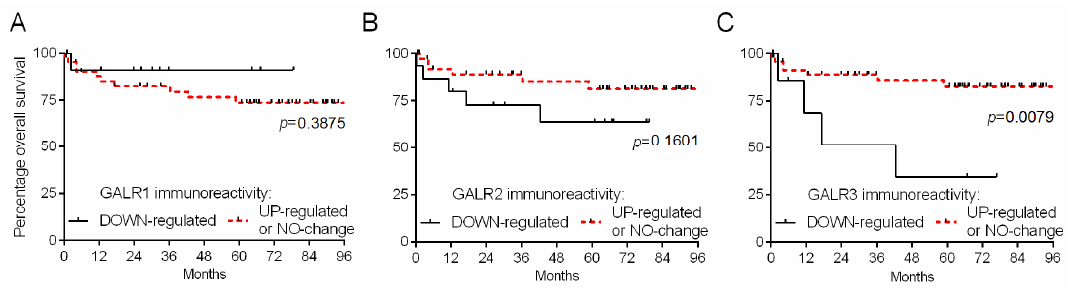
Figure 5. Kaplan–Meier diagrams that show the relative immunoexpression of GalRs regarding the overall survival of colorectal cancer (CRC) patients ( n = 55) ( A – C